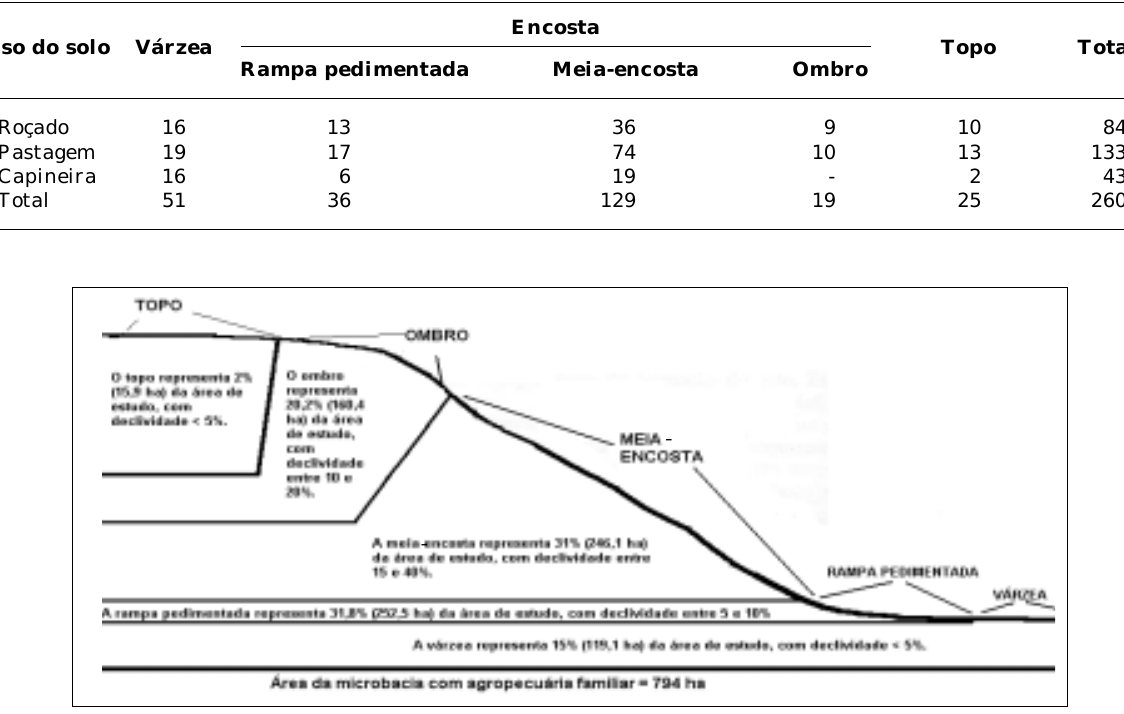
Figura 1. Perfil esquemático das diferentes posições no relevo, seus percentuais e declividades na microbacia Vaca Brava (Santos et al.,